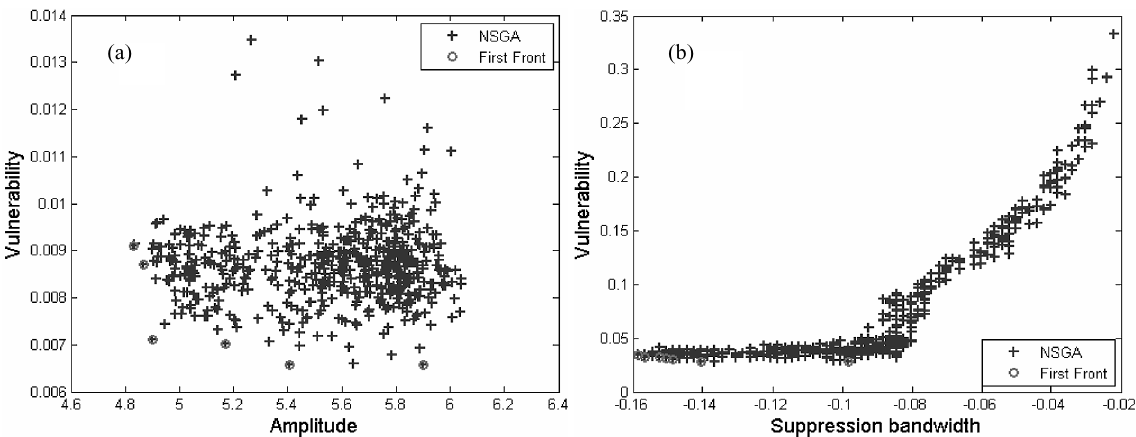
Fig. 10. NSGA solutions and the first front of Pareto for both objective and vulnerability functions.